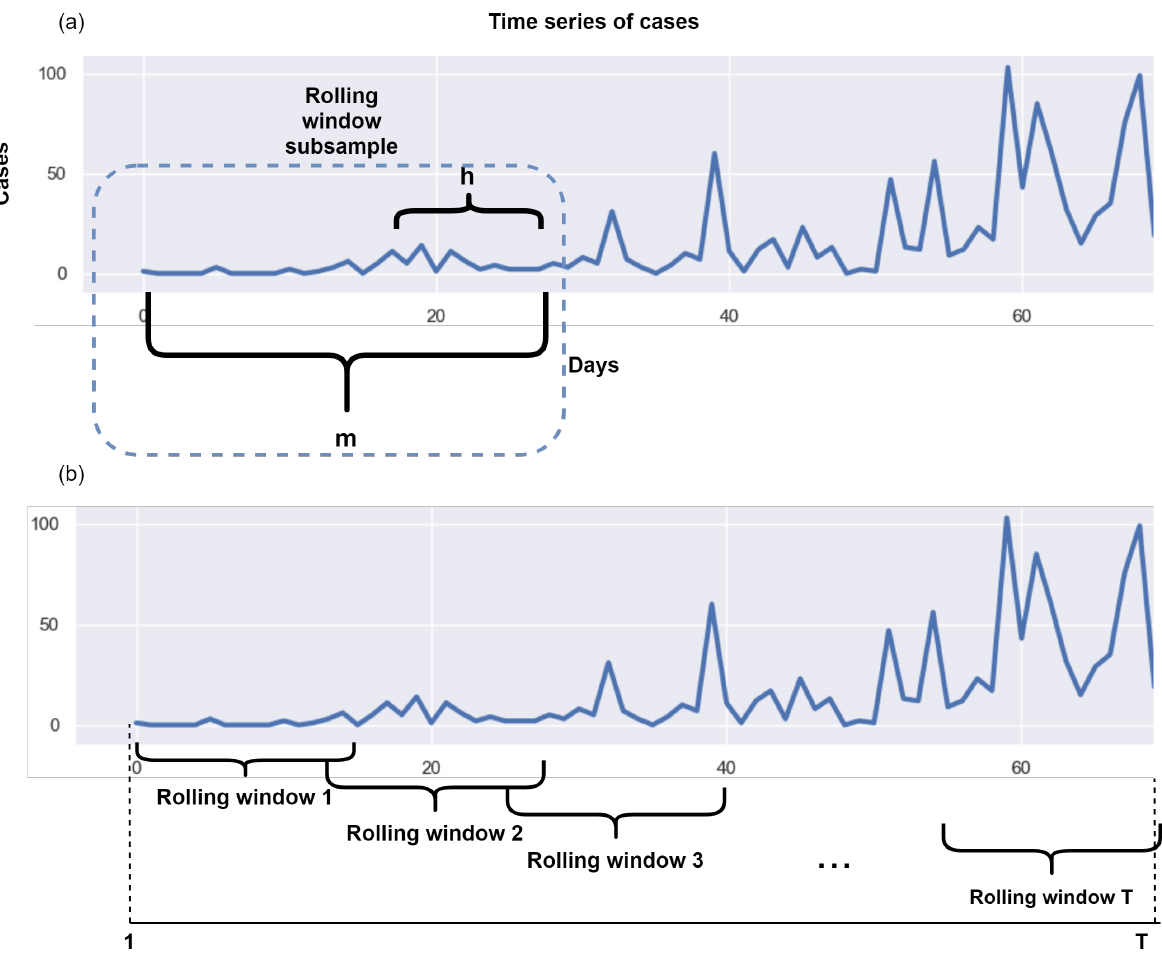
Figure 6. Rolling window sub-sampling method. In (a) we show the rolling window sub-sampling, this method allows us to choose the window size (m), that is, the size of input data to get the prediction horizon (h), that is, the prediction output. In (b) we show how this sub-sampling method runs through the entire time series, setting the inputs and prediction outputs.